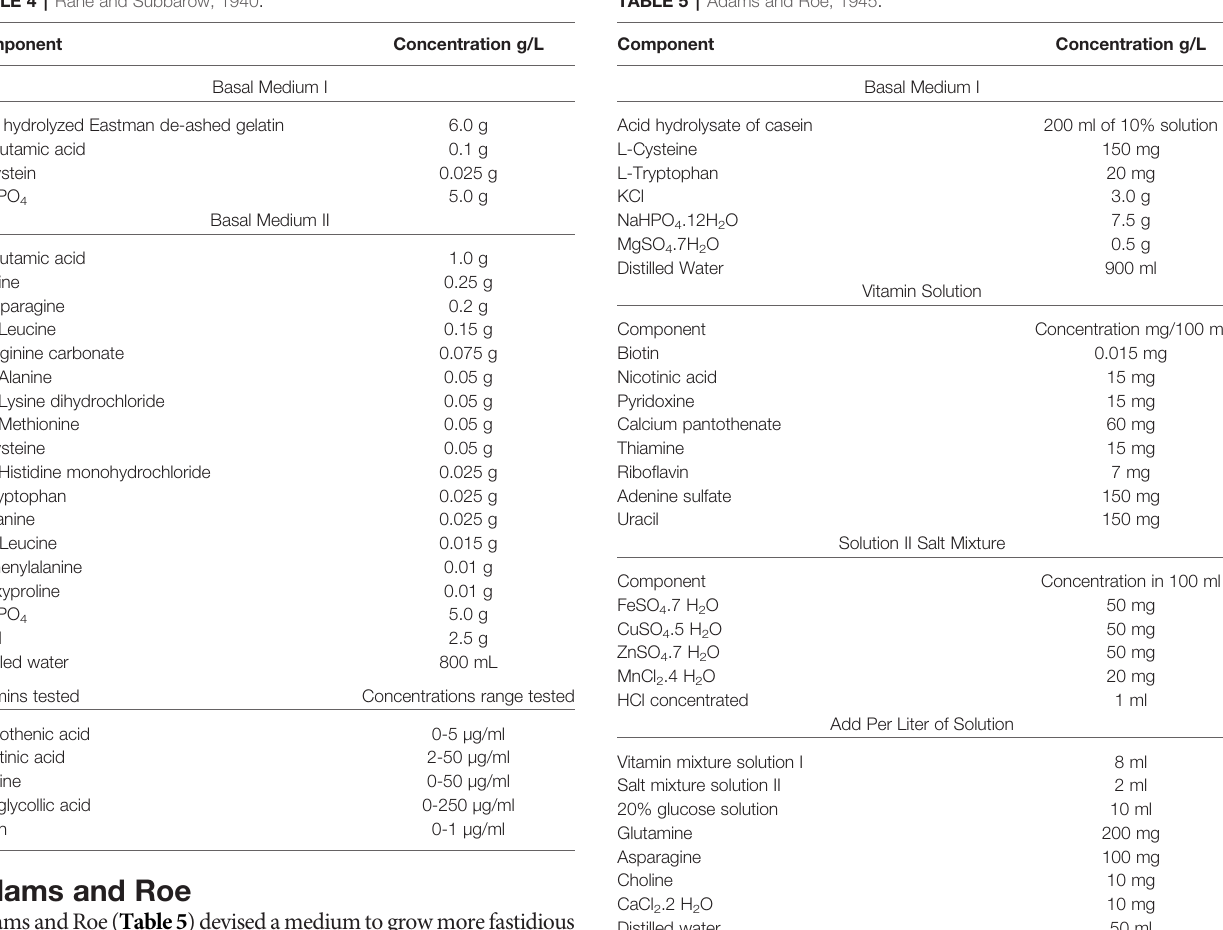
TABLE 5 | Adams and Roe,